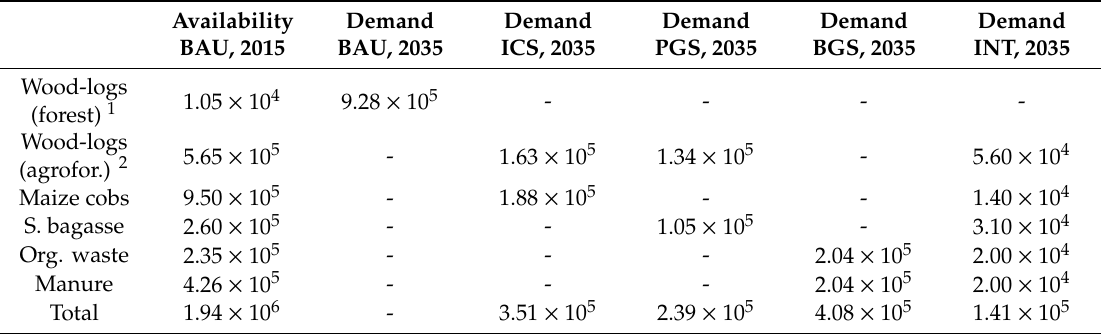
Table 3. Biomass available in BAU, 2015 (t) and use in the BAU, ICS, PGS, BGS and INT, 2035